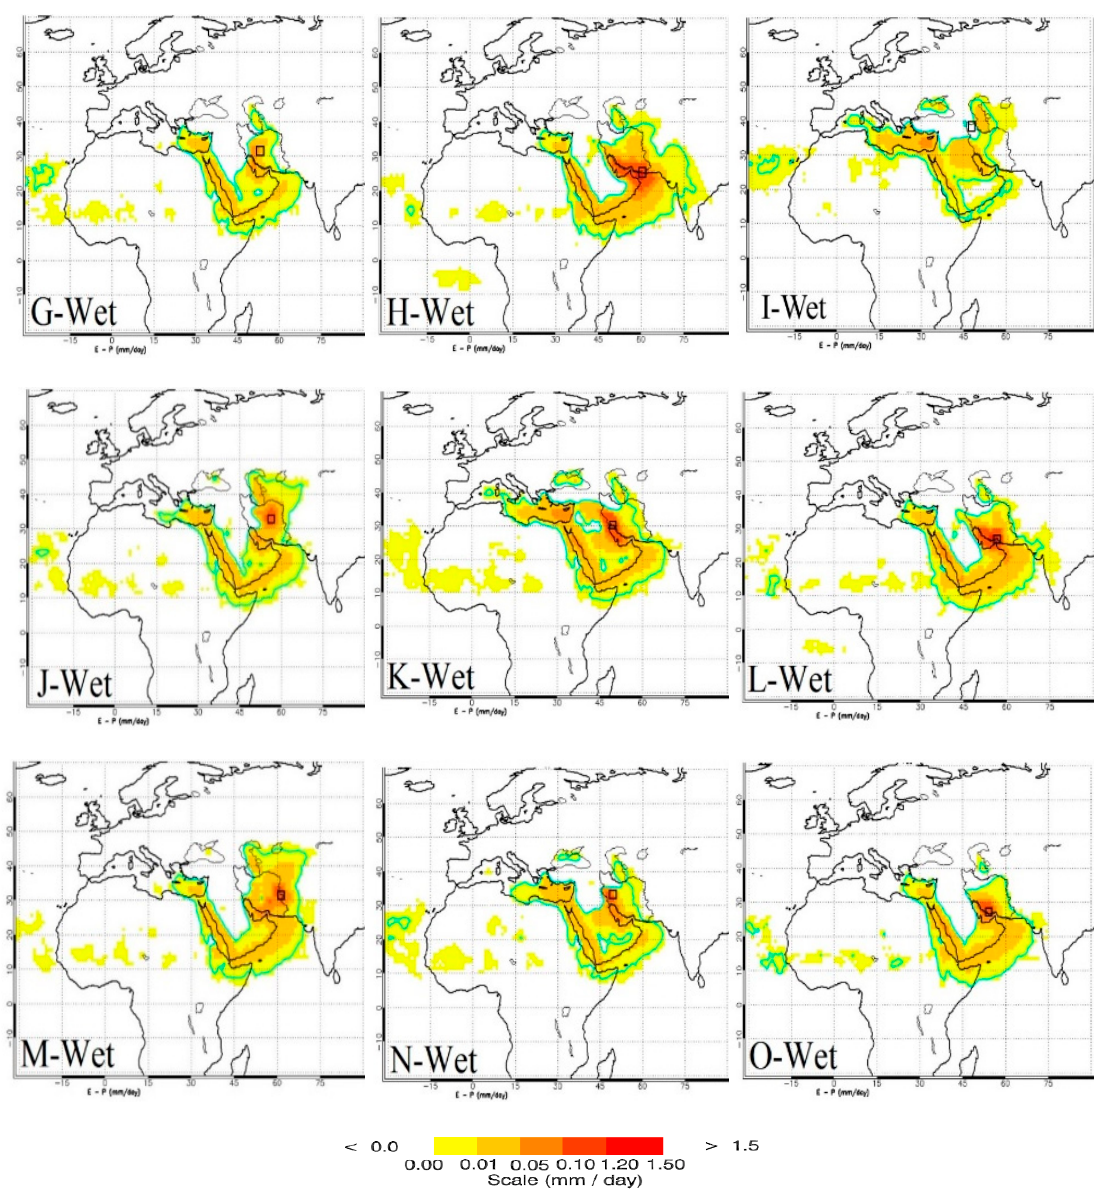
Figure 4. (E-P) backward models in 15 sub-regional locations (from ( A – O )) for the wet season. The light green line shows the boundaries of 95 percentiles of (E-P) > 0.